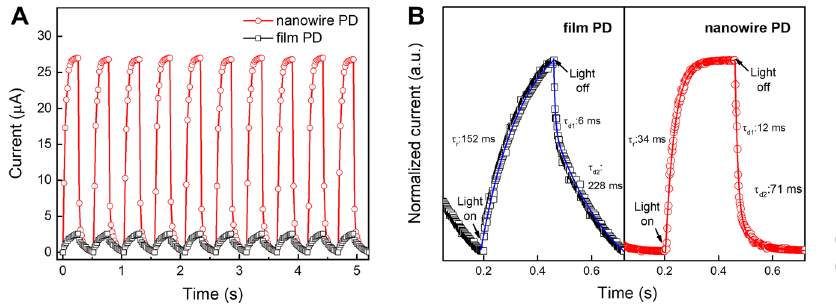
Figure 6: Transient response of photodetectors (PDs) to 266 nm illumination at the bias of 5 V.